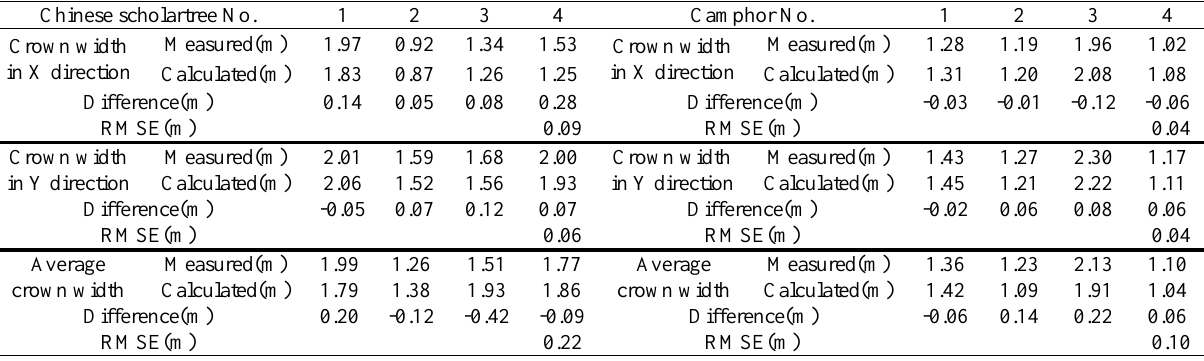
Table 2. Crown width calculation results